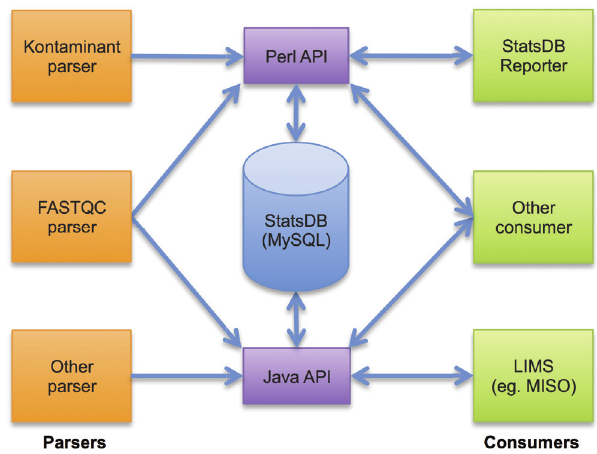
Figure 1. At the core of StatsDB is a MySQL database supported by Perl and Java APIs. Parsers are simple scripts to write the output of QC tools to the database, while Consumers present the database contents to